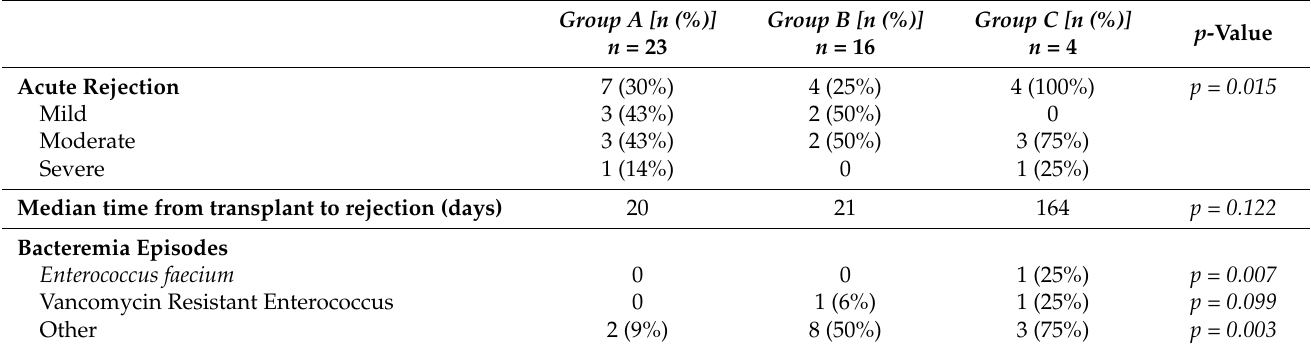
Table 2. Rejection and Infection.